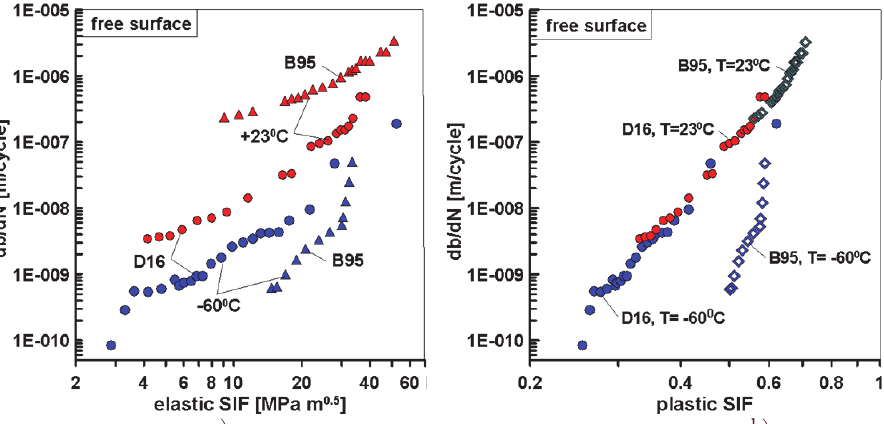
Figure 12: Crack growth rate as a function of (a) elastic and (b) plastic SIFs for both alloys and different temperature conditions.